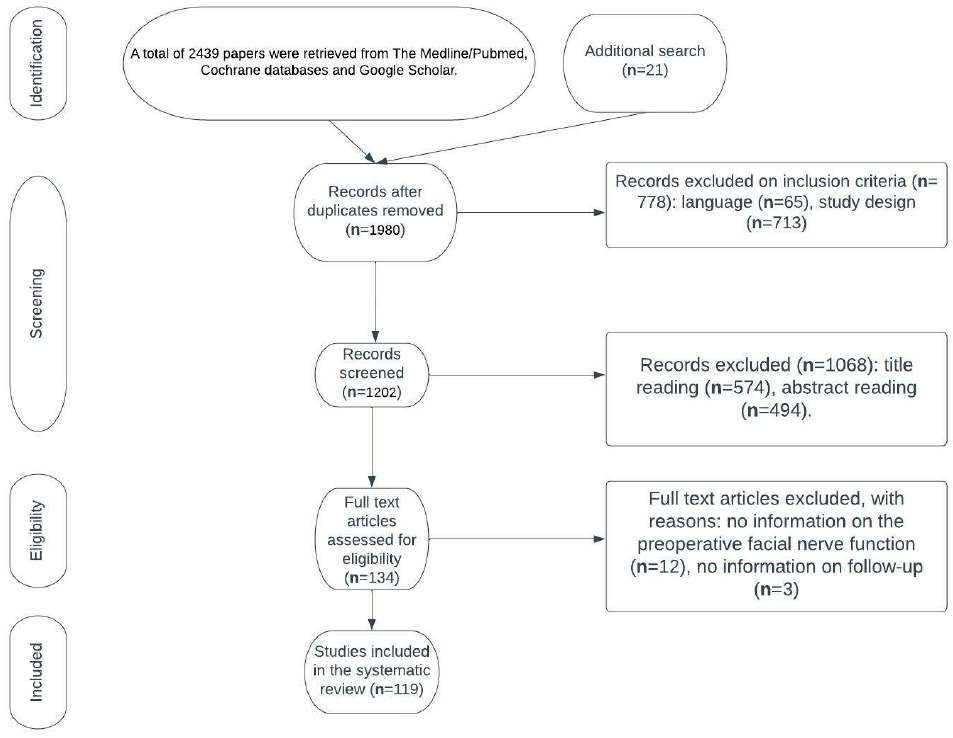
Figure 1. Flow diagram demonstrating article